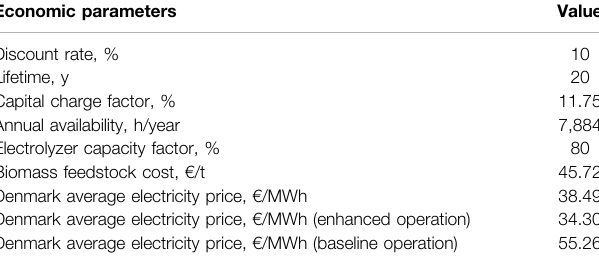
TABLE 8 | Main parameters for the economic analysis. Economic